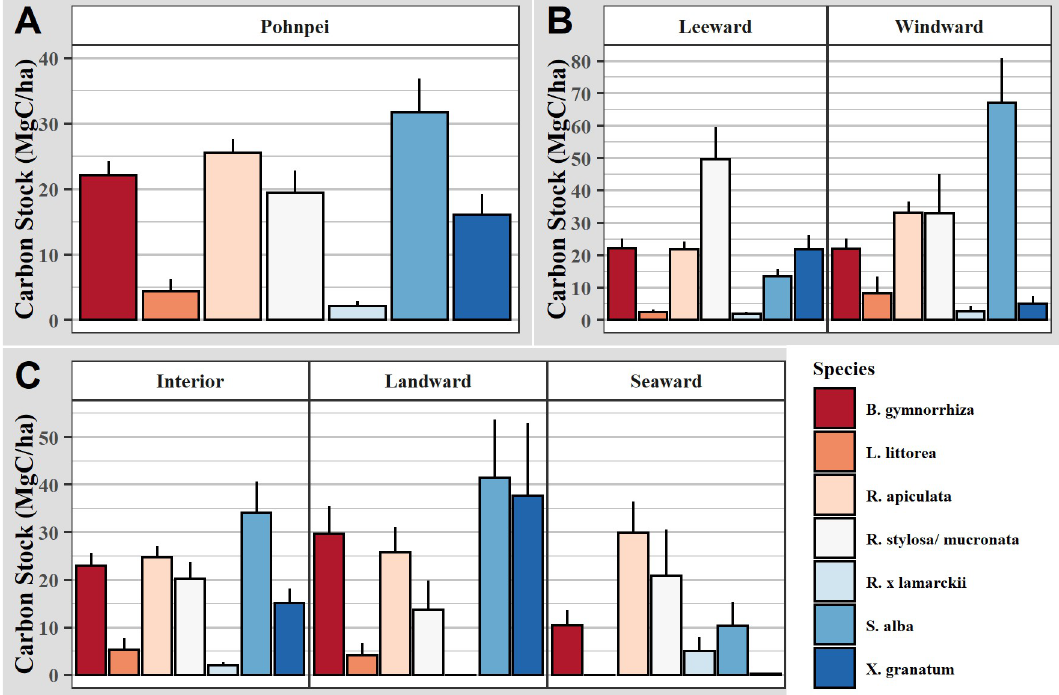
Fig 4. Carbon stock of mangrove species. Bar graphs showing mean and standard error of standing tree carbon stock (MgC ha -1 ) by dominant mangrove species on: A) Pohnpei Island-wide, B) island sides (windward vs leeward), and C) island zones (seaward, interior, vs landward). Island sides are shown in Fig 1 and zones are discussed in the